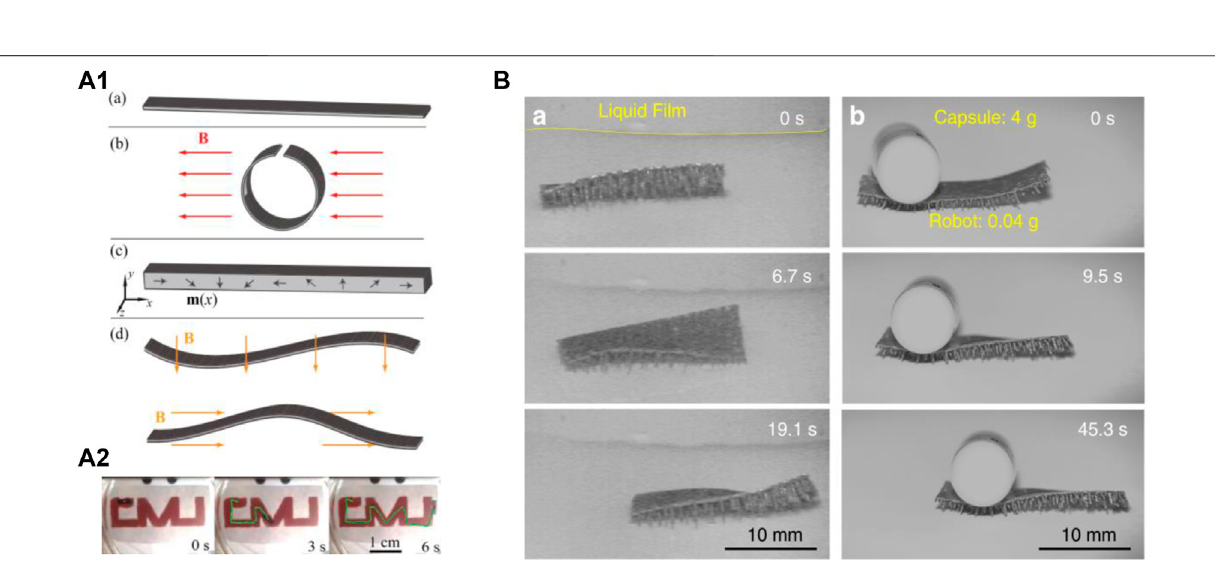
FIGURE 6 | (A1) Continuous-magnetization-pro fi le fabrication method, a direction varying magnetization pro fi le is created by folding the soft materials when it is magnetized. (A2) Controlled path following of the robot on the water surface. Reproduced from Diller et al. (2014) with permission of AIP. (B) The robots move with an average speed of 0.5 mm/s on wet surface under a drive frequency of 1 Hz and move 8 mm in 45 s with a loading 100 times of its own weight. Reproduced from Lu H. et al. (2018) with permission of Springer